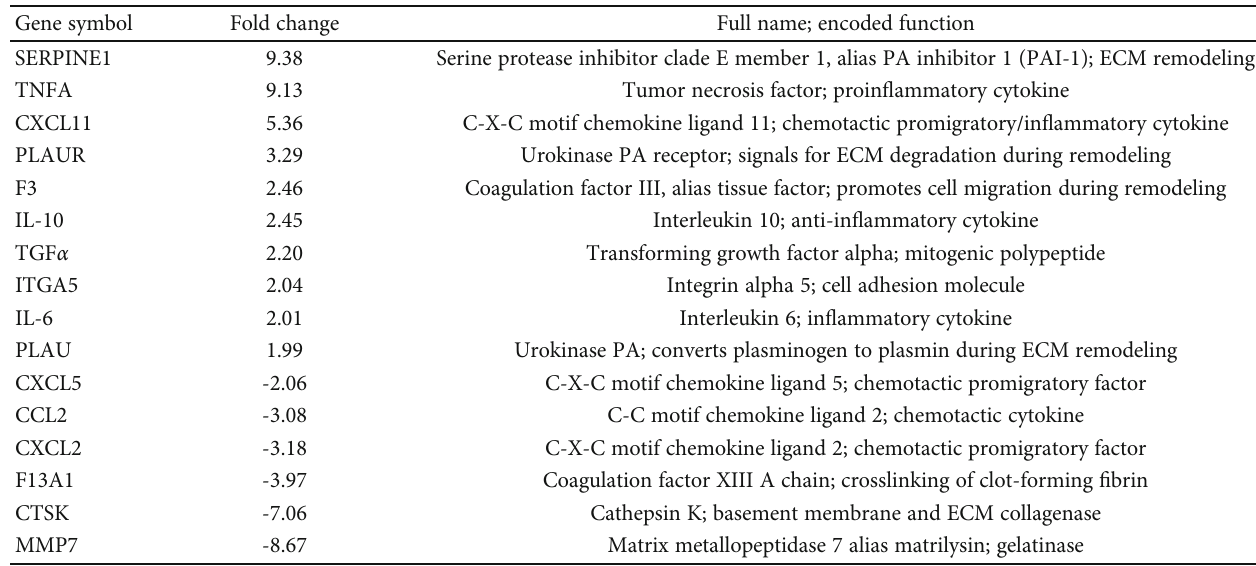
Figure 2: TNIP1 de fi ciency and low-level exposure to poly (I:C) promotes increased expression of EMT, epithelial tissue remodeling, and in fl ammation markers. (a, b) Gene expression was measured from HaCaT keratinocyte RNA collected 6hr post-poly (I:C) (1 μ g/mL) treatment. mRNA levels were measured by qRT-PCR, normalized to RPL13a, and shown as fold change relative to nontargeting siRNA and vehicle-treated cells. (c) Secreted CCN2 was detected using supernatant collected 12hr post-poly (I:C) (1 μ g/mL) treatment from cells transfected with either nontargeting or TNIP1 siRNA. Data is presented as mean + SEM from two independent experiments with conditions in each set in triplicate. For (a), means with a common letter are not signi fi cantly di ff erent by two-way ANOVA followed by Tukey ’ s post hoc test at a signi fi cance level of p ≤ 0 : 05 . For (b) and (c), p ≤ 0 : 01 . Table 1: TNIP1 de fi ciency in HaCaT keratinocytes promotes altered expression of genes associated with wound healing. qRT-PCR array results from HaCaT keratinocytes treated with TLR3 agonist poly (I:C) for 6hr. Transcript fold changes, with values normalized against housekeeping gene transcript RPLP0, were calculated between poly (I:C)-treated HaCaT keratinocytes previously transfected with either nontargeting or TNIP1 siRNA. PA: plasminogen activator; ECM: extracellular matrix; C-X-C: Cys-X-Cys amino acid